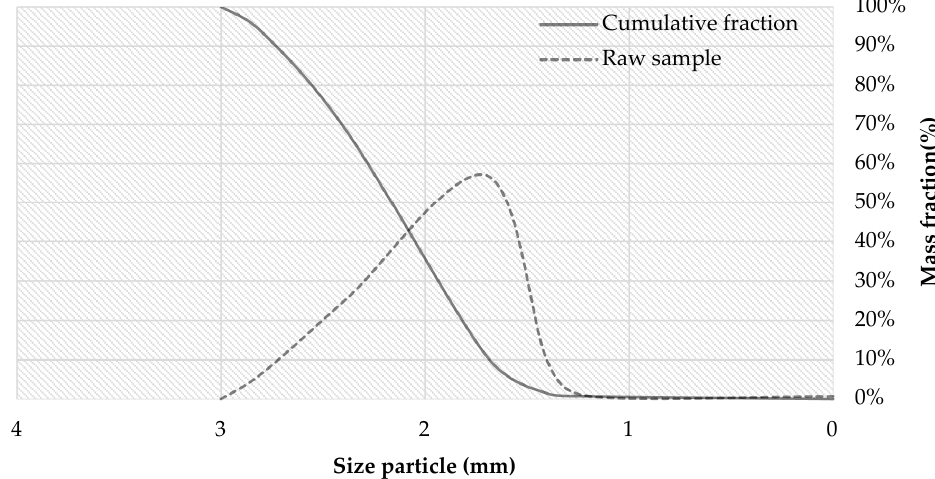
Figure 1. Particle size distribution of wood particles.